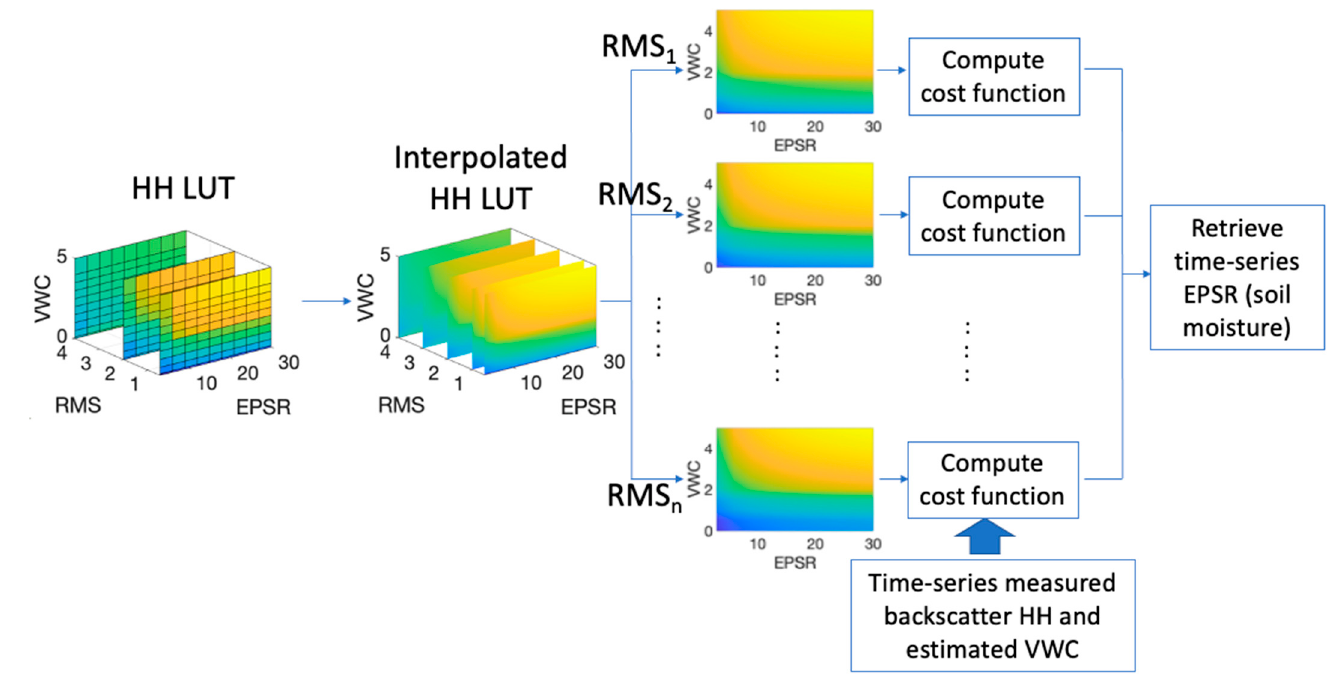
Figure 3. Time-series retrieval algorithm flow. RMSi is a candidate of time-invariant estimate of roughness. EPSR stands for real part of dielectric constant. Unit for VWC and RMS are kg/m 2 and cm, respectively.